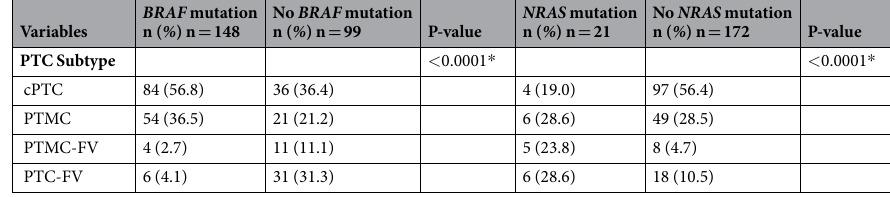
Table 1. Frequency of Primary BRAF and NRAS mutations in cPTC, PTMC, PTMC-FV and PTC-FV. * Significant difference.